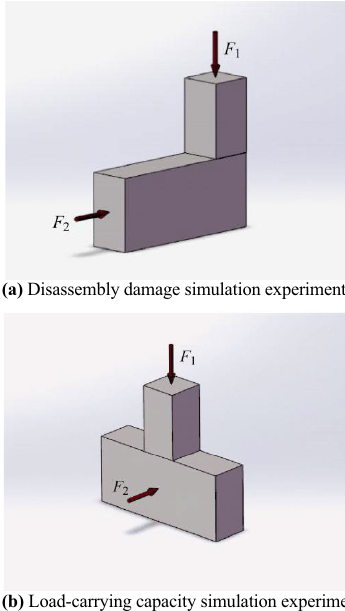
(b) Load-carrying capacity simulation experiment Figure 2 Simplified experiment model of interference fit (contact area: 10 mm 10 mm; F1, the vertical force applied by experiment × platform; F2, the horizontal force applied by experiment